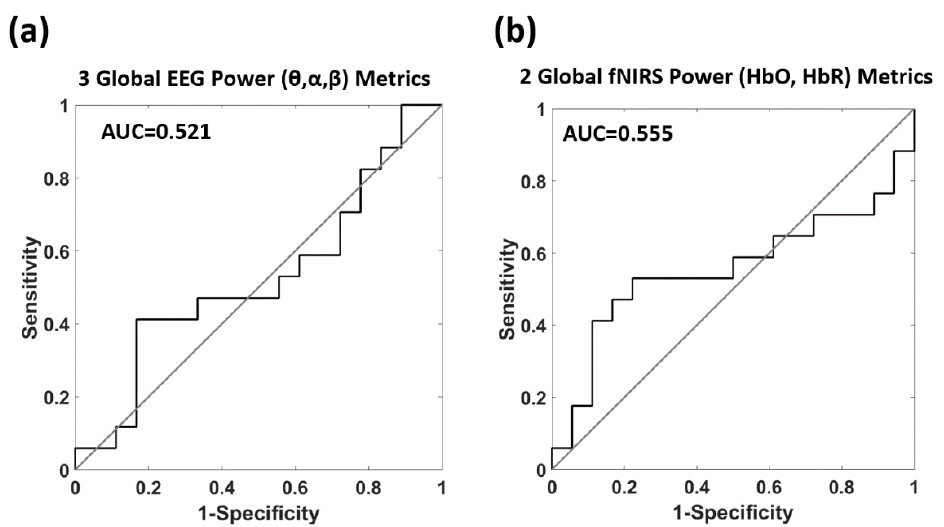
Figure 8. CV classification outcome of the multivariate data-driven analysis predicting AD and HC from the standalone EEG and fNIRS metrics. ( a ) ROC analysis employing the 3 global EEG powers. ( b ) ROC analysis employing the 2 global fNIRS hemoglobin powers.